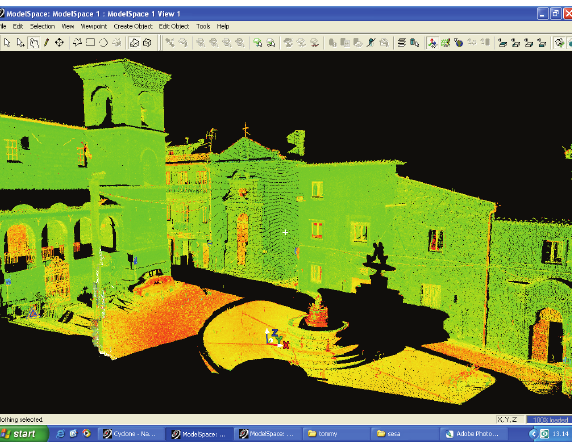
Figure 4. View of Francesco Neglia square’s point cloud After that, operations continued manually through the identification of homologous points on pairs of scanned images, by linking together each scanned image to the previous one using the polygonation method. Calculation parameters (subsample percenting, number of interactions, max search distance) were optimised in order to minimise alignment error between scanned images which on average was about 2/3